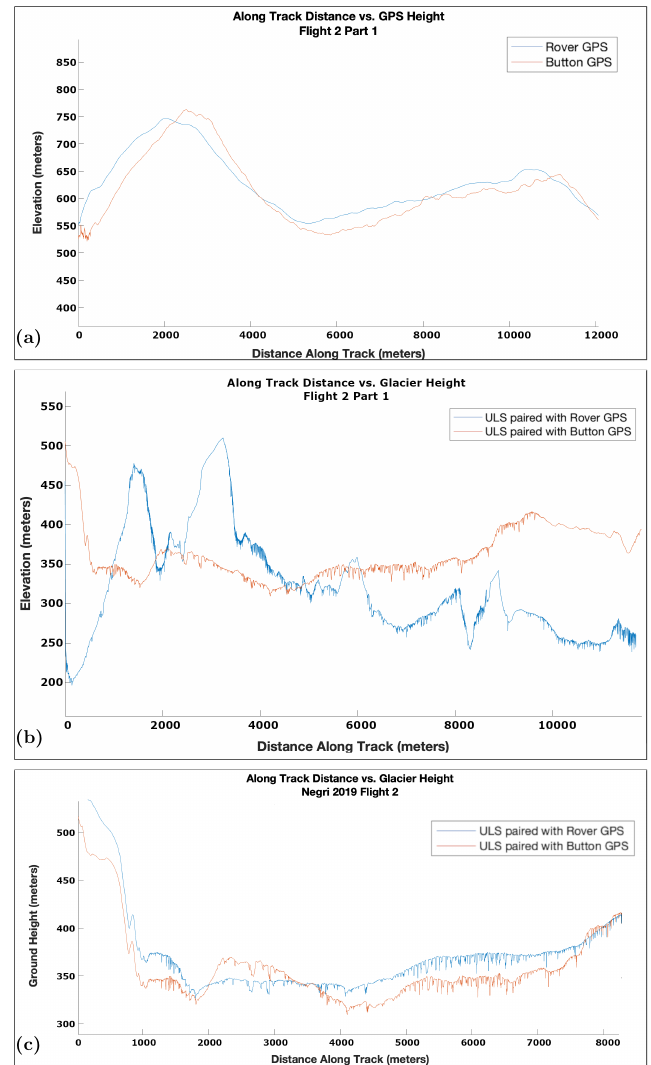
Figure 5. Illustration of the process of surface-height determination from synchronization of ULS and GPS data. Negribreen validation campaign. Flight 2, 13 August 2019. Corrected GPS data are